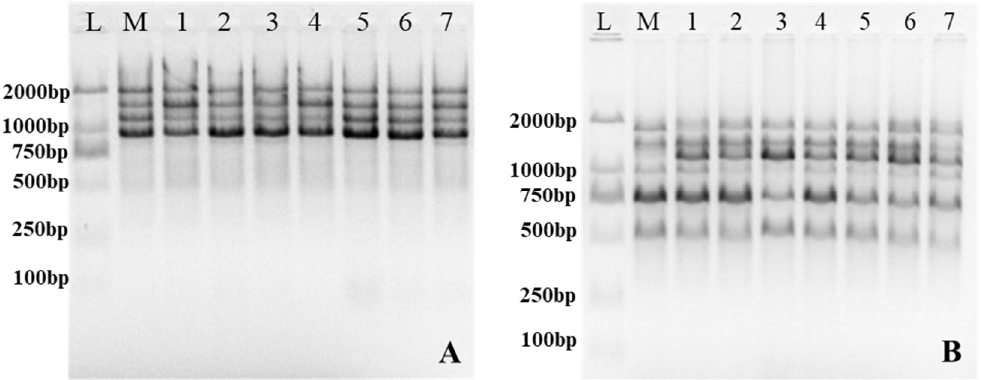
Figure 2. ISSR profiles generated by PCR amplification. Lane L: Molecular marker (2000 bp);